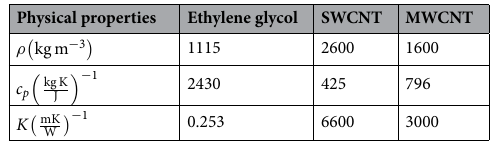
Table 3. Thermophysical properties of EG and CNTs 47,50